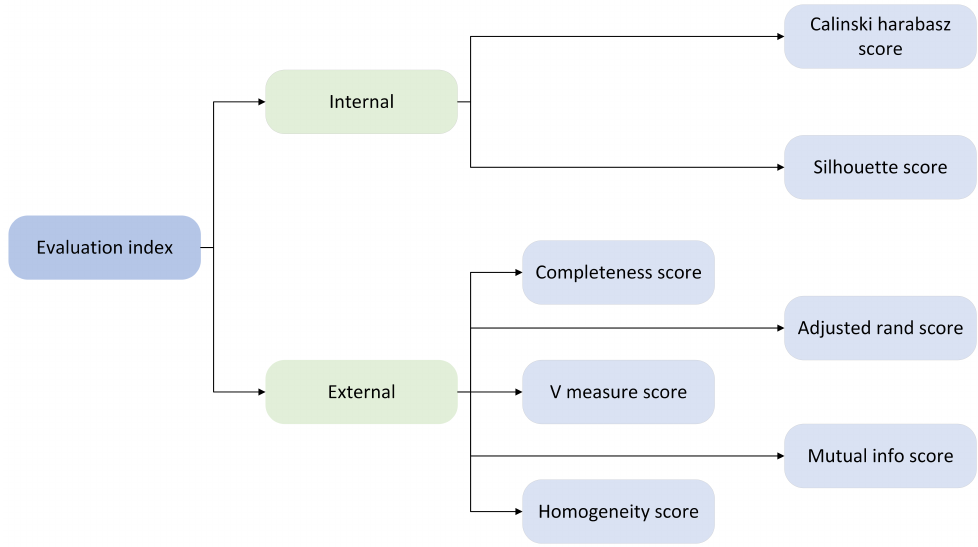
Figure 4. Seven internal or external metrics for evaluation of clustering